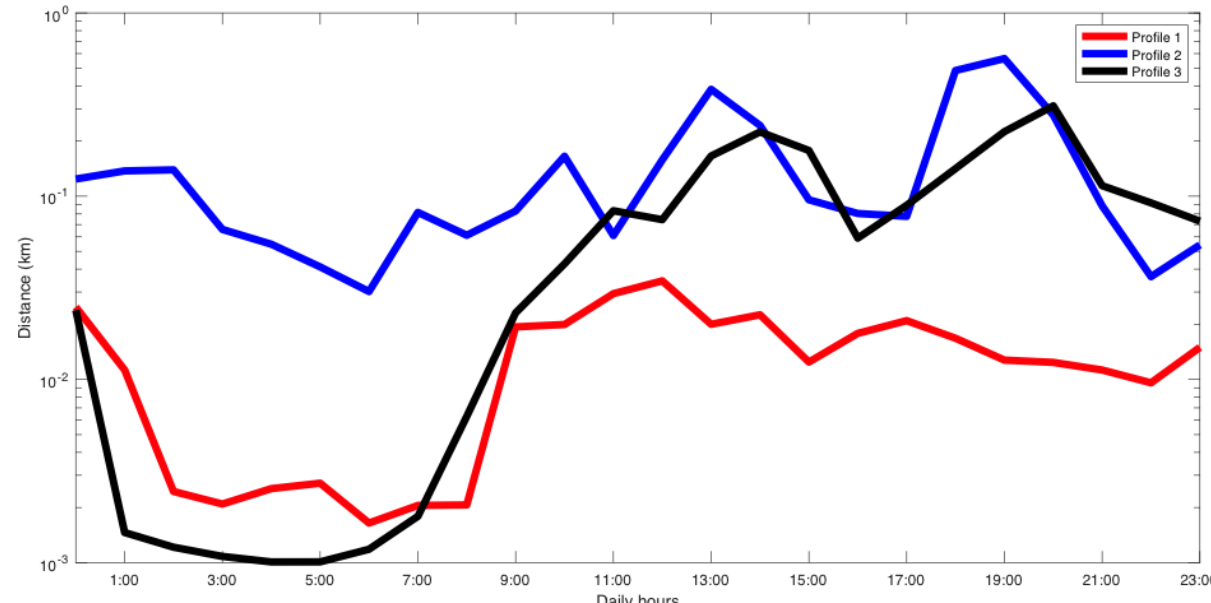
Figure 11. Distance traveled profiles of patient E.